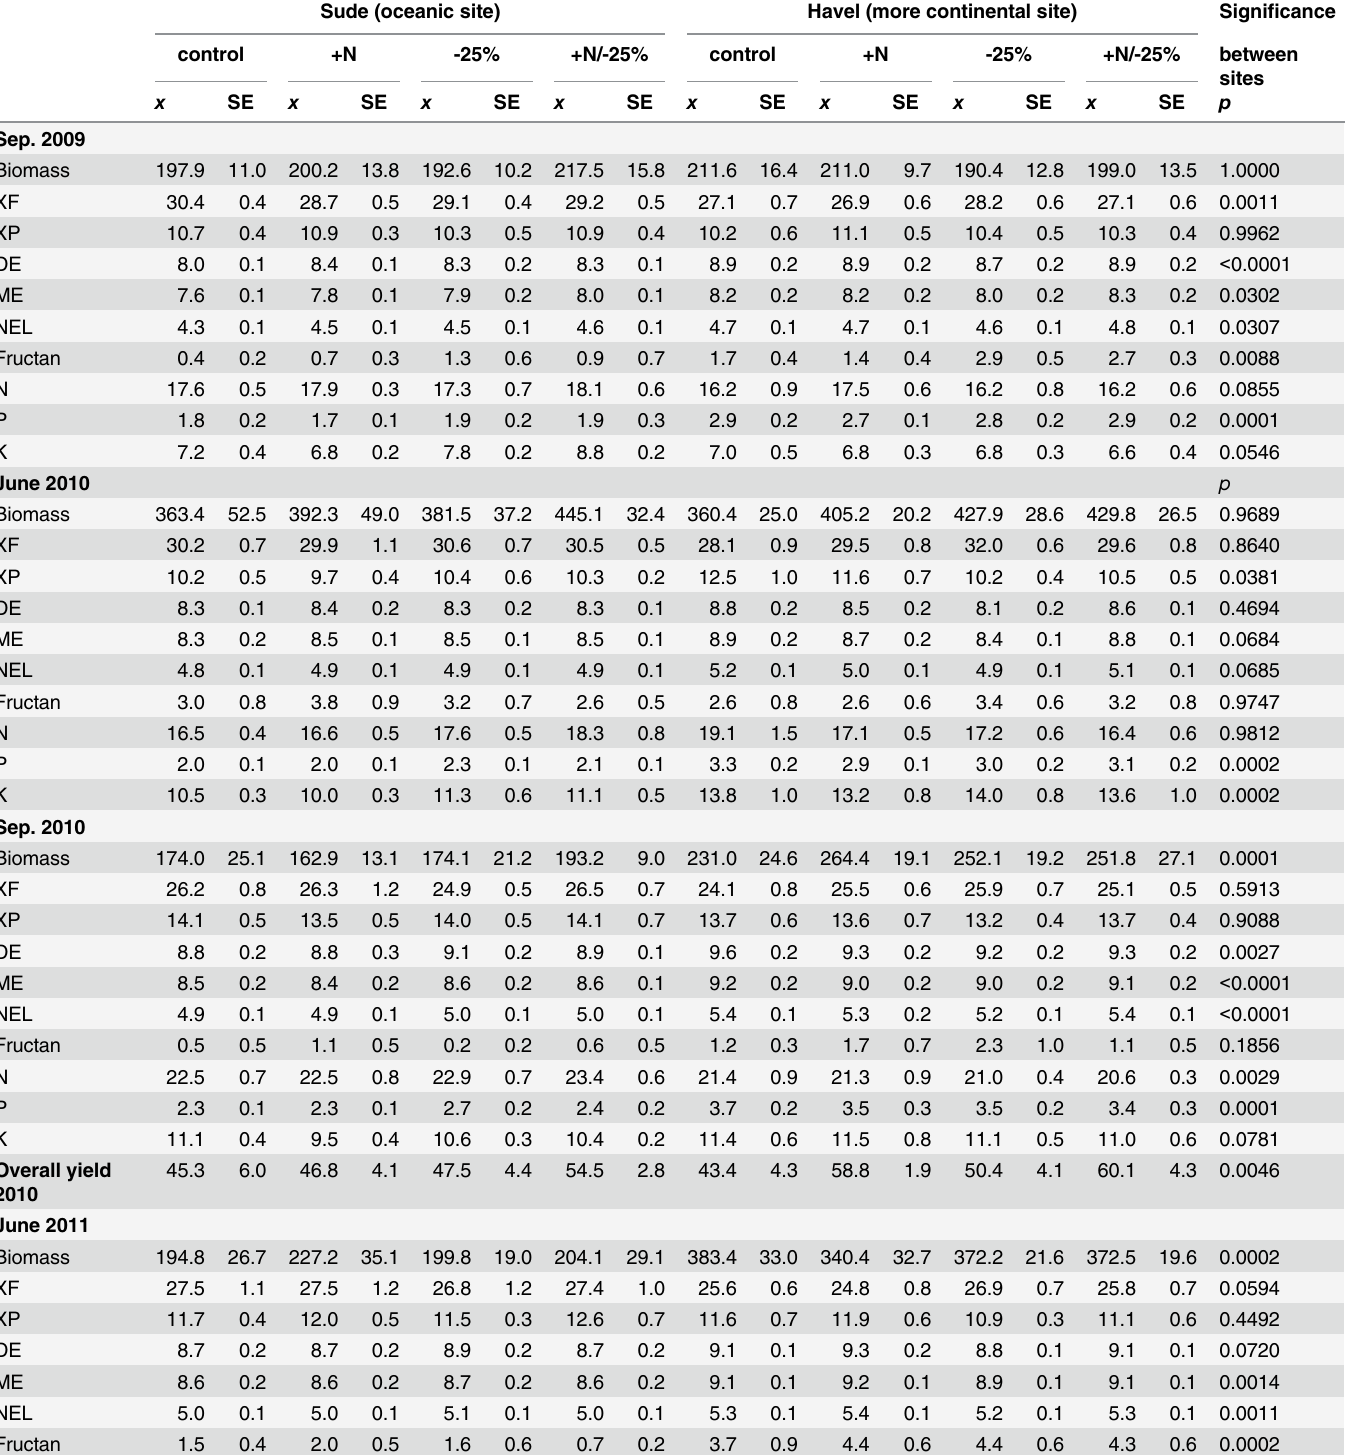
Table 3. Forage quality parameters of differently treated meadow plots (control, +N, -25%, and +N/-25%) at the Elbe tributaries (oceanic site at the Sude and more continental site at the Havel River). Sude (oceanic site) Havel (more continental site) Signi fi cance